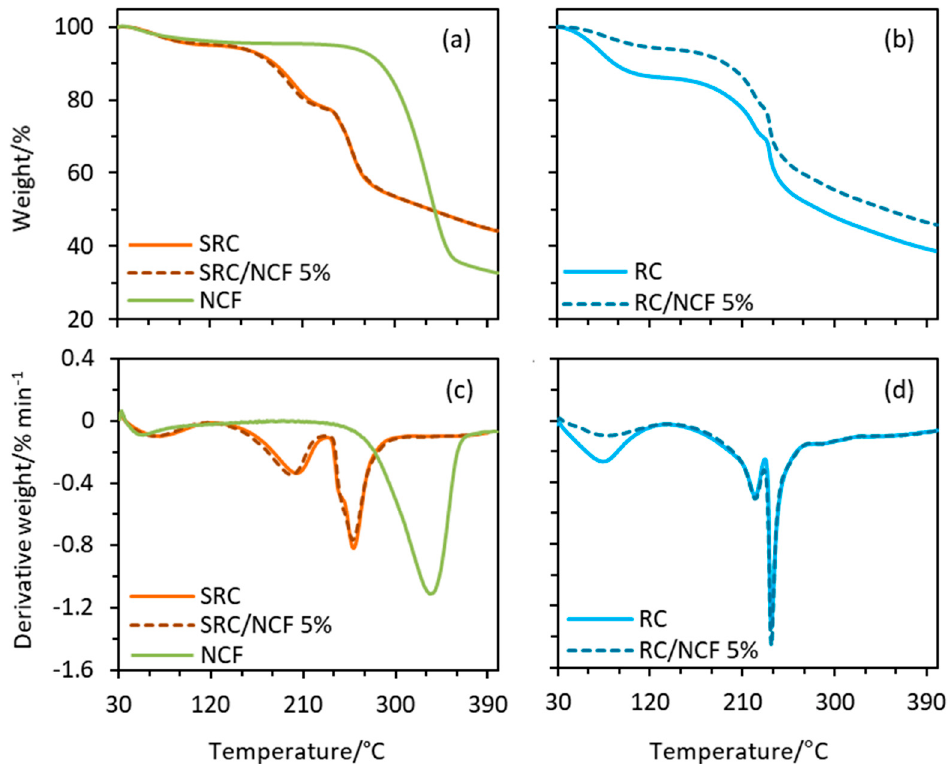
Figure 5. Thermogravimetric (TG) plots of normalized weight for ( a ) SRC/NCF and ( b ) RC/NCF films and derivative weight for ( c ) SRC/NCF and ( d ) RC/NCF film. Samples were heated from 30 to 400 °C